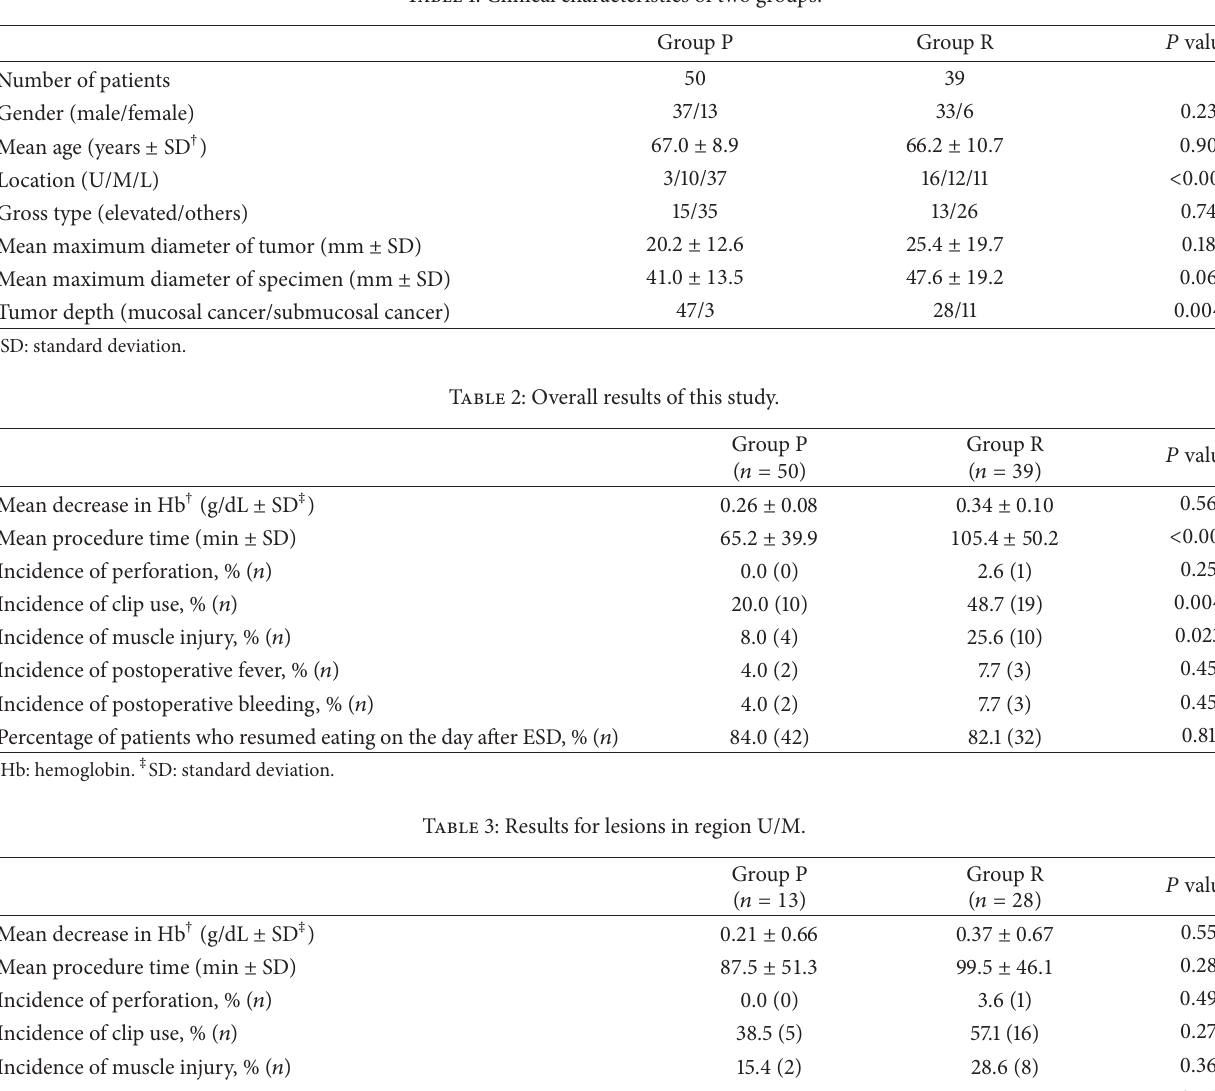
Table 1: Clinical characteristics of two groups.